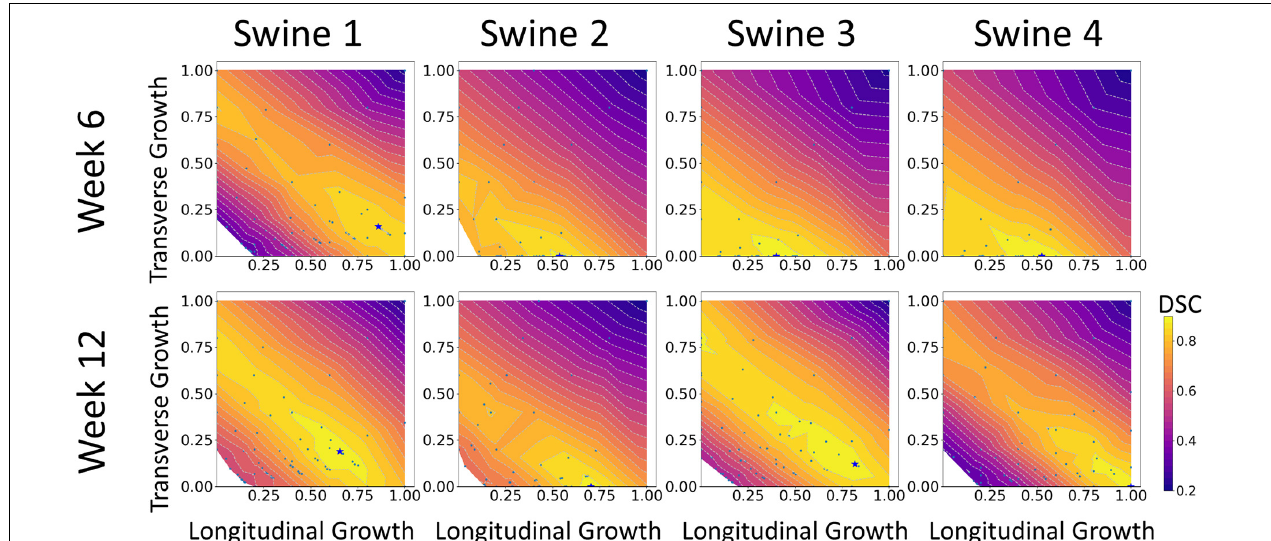
FIGURE 9 | DICE score heatmaps of growth parameter prediction for four exercised animals at two different time points (weeks 6 and 12).